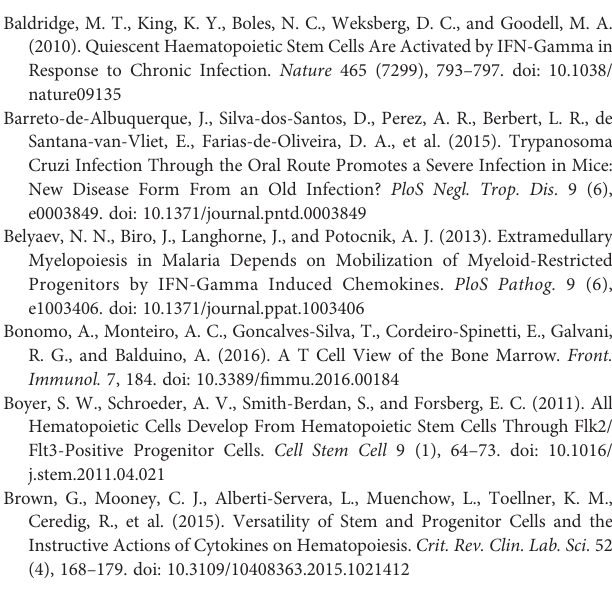
Supplementary Figure 1 | Flow cytometry gating strategy for analyzing bone marrow progenitors. The gate strategy was de fi ned by backgating Lin - cells within FSC vs SSC dot plot. Follow this setting, the graph was ungated and all analyses were performed in singlets. The positive expression of progenitor cell markers was based on FMO controls to check for fl uorescence spread and isotype controls to determine the level of non-speci fi c binding. Supplementary Figure 2 | Parasitemia quanti fi cation. Male BALB/c mice were infectedthroughtheoralcavitywith5×10 4 insect-derivedmetacyclicformsof T.cruzi . Parasitemia(mean and SEM) was assessed during the acute phase. Parasitemia was calculated bythe Pizzi-Brener method. The total number of animalsin each time point was obtained from different experiments. n: 7 dpi =21, 10 and 14 dpi = 15, 18 dpi = 18, 21 dpi = 11, 23 dpi = 6, 28 dpi = 8, 36, 40, 42, 46, 48 and 53 = 4. Supplementary Figure 3 | immuno fl uorescence of bone marrow following orally induced T. cruzi acute infection. (A-C and D-F) represent respectively immuno fl uorescence for T. cruzi detection of femur sections of infected mice at 14 dpi and 21 dpi. Representative micrographs derive from experiment with 5 mice at 14 and 21 dpi. The tissue was labeled with primary antibody with reactivity to T. cruzi and secondary antibody anti-mouse Alexa Fluor 488, green; eosinophil auto fl uorescence, red; and nucleus, DAPI, white. Bars show the magni fi cation of each micrograph. Supplementary Figure 4 | Splenic evaluation throughout acute phase of T. cruzi infection. (A) Spleen size measurements were made in all tissue sections in the control and infected mice at 7, 14 and 21 dpi. Panels (B, C) depict panoramic view and a higher magni fi cation of the red pulp area showing exacerbated red pulp at 14 dpi. Panels (D, E) reveal similar areas at 21 dpi mice. Apparent megakaryocyte hyperplasia (*), intense erythropoiesis (E) and incipient myelopoiesis foci (M) were signposted. Tissue sections were stained by hematoxylin and eosin. The data are representative of 5 mice per group, both at 14 and 21 dpi. Bars show the magni fi cation of each micrograph in each panel. The data are representatives of an experiment with 8 animals from control and 5, 3 and 5 animals from infected mice, at 7, 14 and 21 dpi, respectively. Statistical differences were ascertained with the Two-way Anova test with